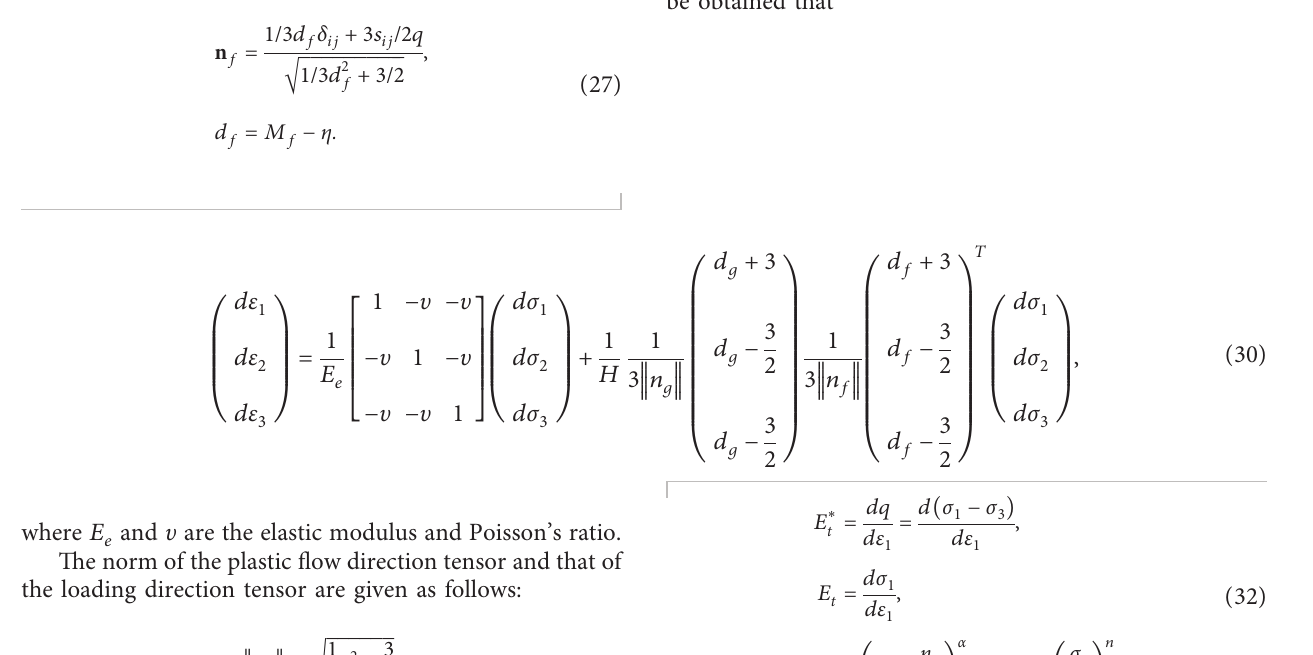
Figure 14: Various stress path tests of Yixing rockfill materials